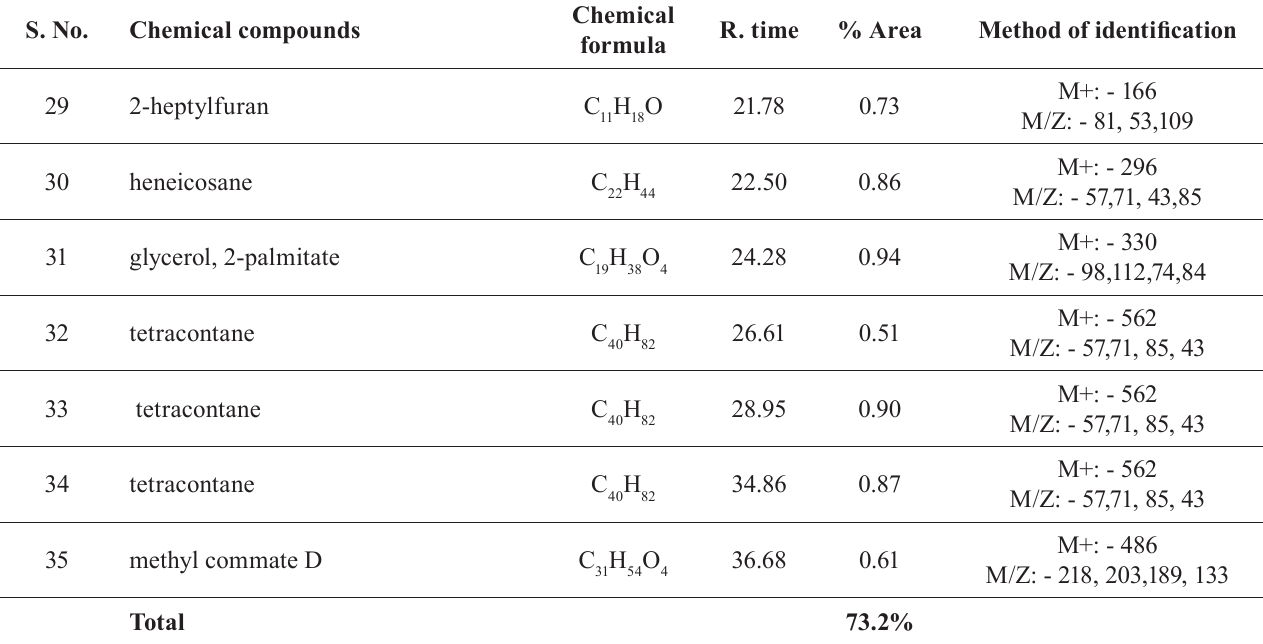
TABLE I - C hemical composition of hexane extract of whole plant of A. uliginosa